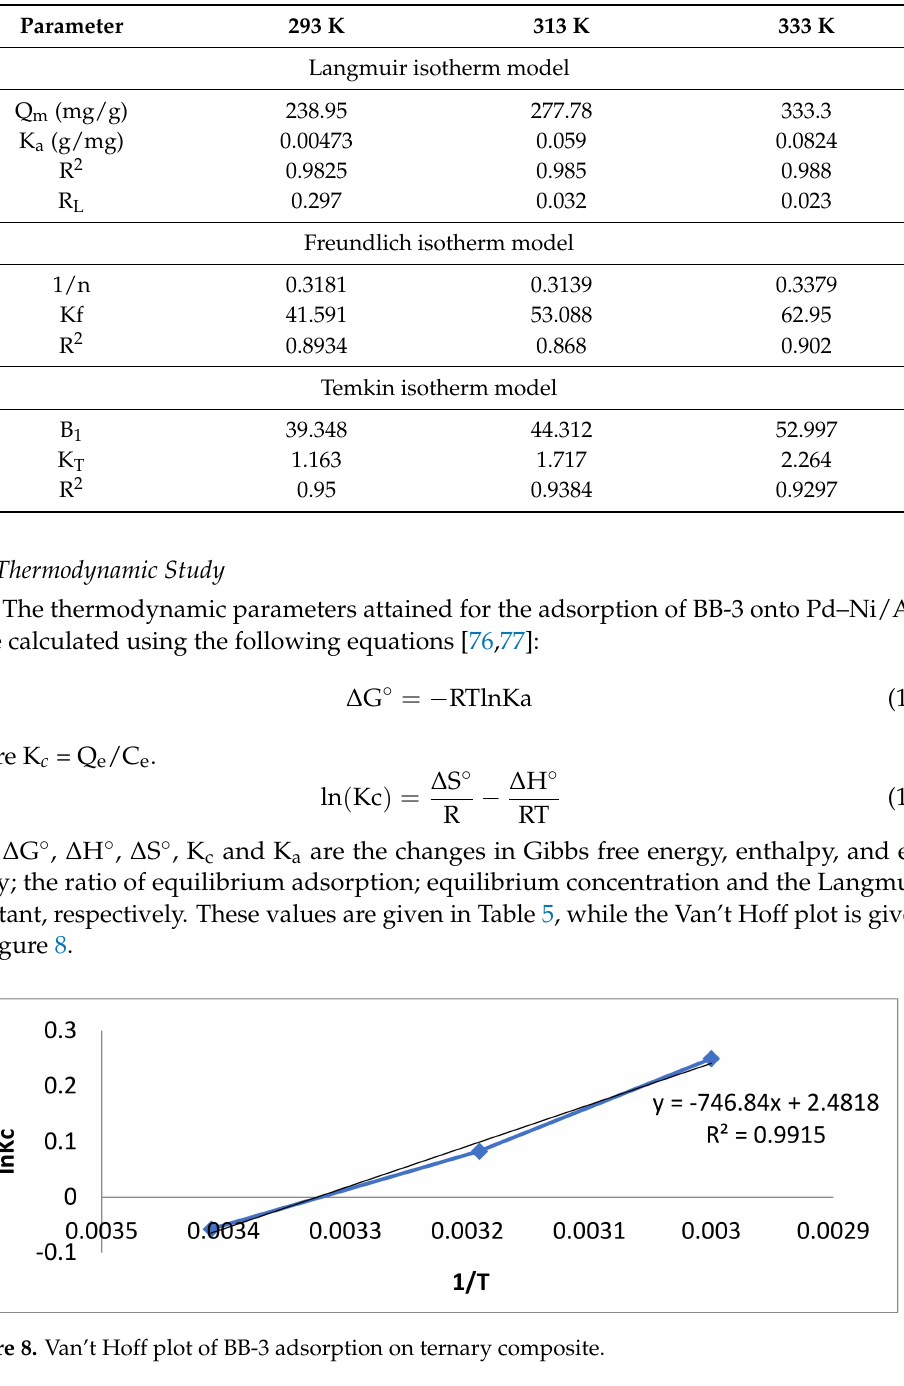
Table 4. Parameters of isotherm study for adsorption of the BB-3 on Pd–Ni/AC.